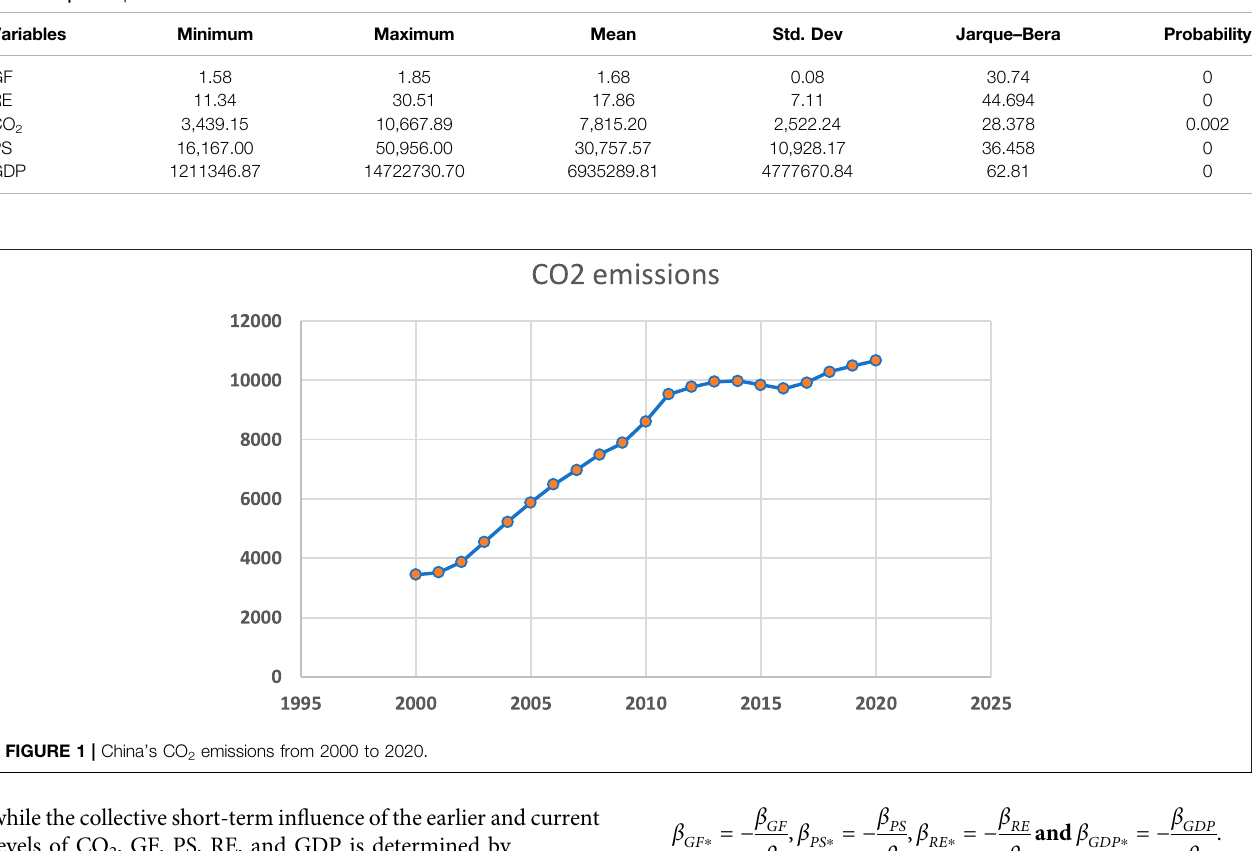
TABLE 2 | Descriptive statistics outcomes.